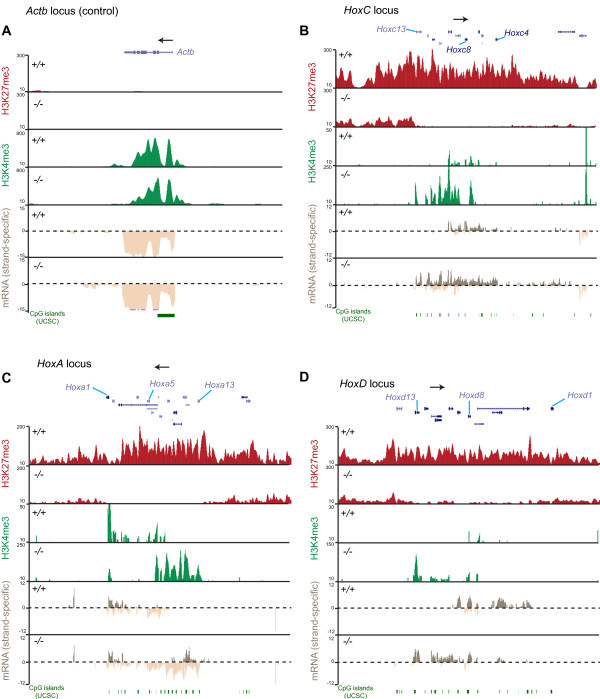
Hox gene clusters are mis-regulated in Dnmt1-/- mouse embryonic fibroblasts. Browser shots from the UCSC genome browser showing H3K27me3 (red) and H3K4me3 (green) ChIP-seq data, and strand-specific mRNA-seq data for the (A) Actb, (B) HoxC, (C) HoxA and (D) HoxD loci in Dnmt1+/+ and Dnmt1-/- MEFs. The position of RefSeq genes (blue) is shown along with the direction of sense transcription for the Hox genes (black arrow). The position of UCSC CpG islands (green) is shown. ChIP-seq data is represented as the number of reads that overlap genomic windows. Note the different scales used for H3K4me3 data. mRNA-seq data is represented as the number of reads that overlap genomic windows (log2) on each strand (above and below the dashed line).